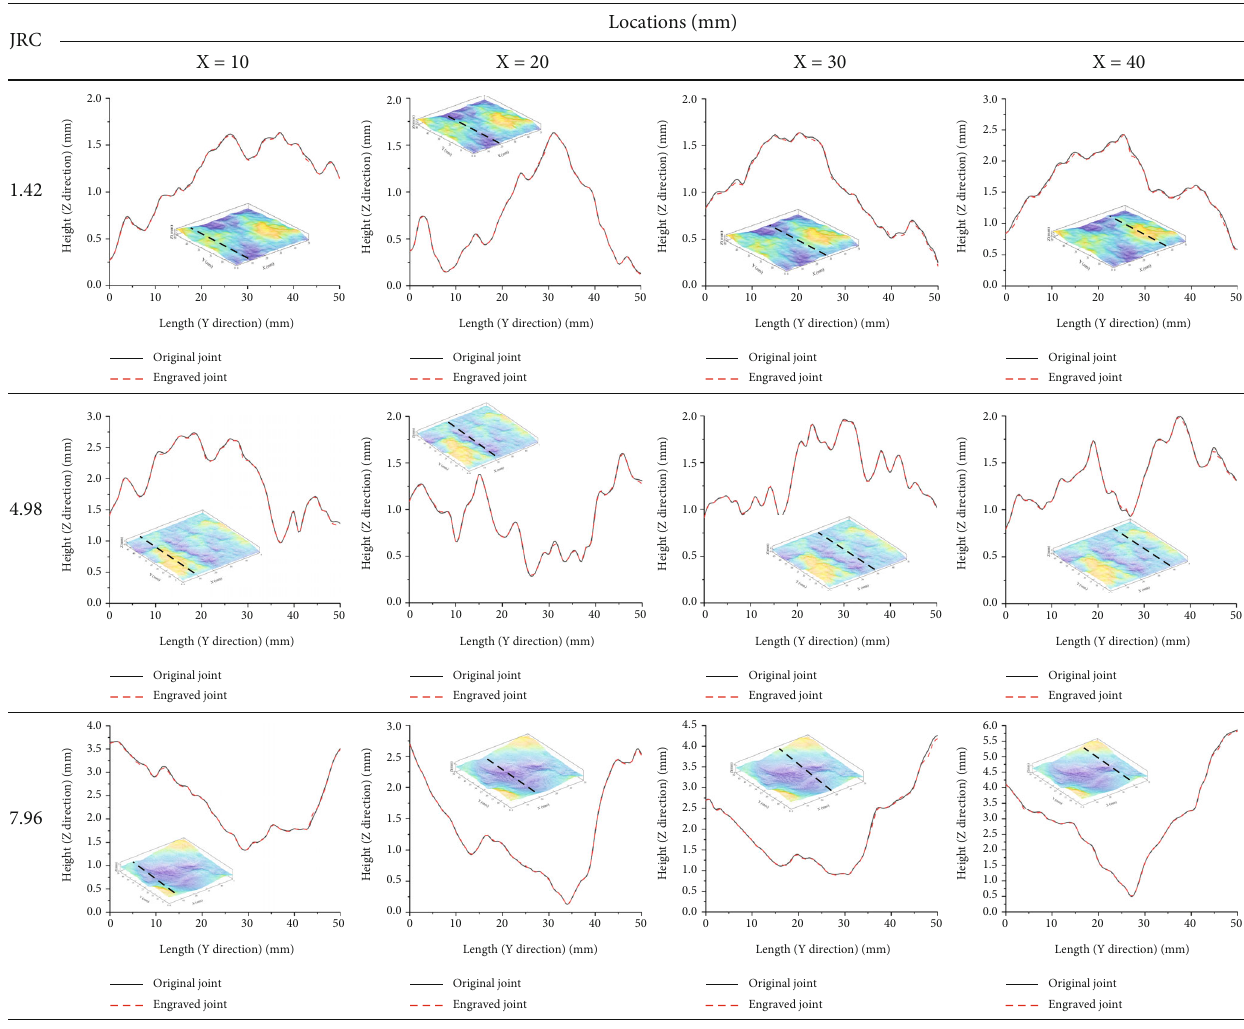
Figure 4: Comparison through 2D pro fi les at di ff erent locations ( X ) between the original and engraved joints surfaces, where X = 10, 20, 30, 40 mm mean pro fi le positions in X direction.